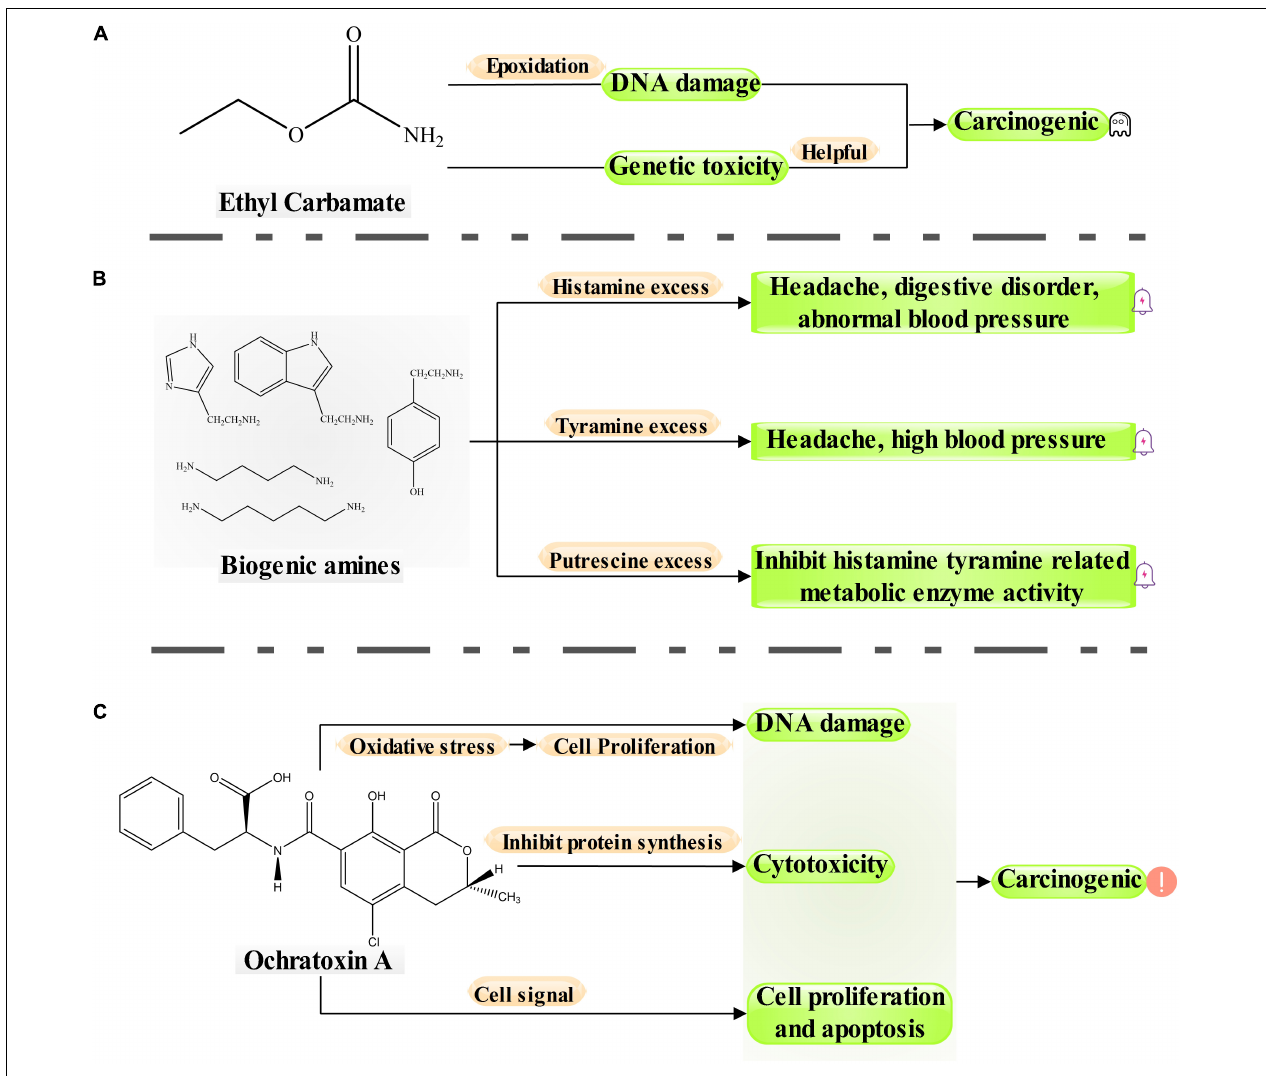
FIGURE 1 | Hazard process of biologically harmful products (ethyl carbamate, biogenic amines and ochratoxin A) in